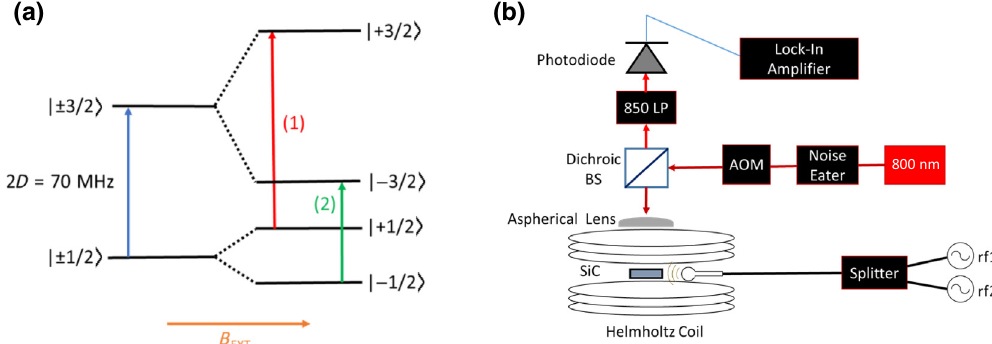
FIG. 1. V2 ground state and experiment setup. (a) Energy-level structure of V2 center with an external magnetic field oriented along the c -axis splitting the degeneracy of the |± 1/2 (cid:4) and |± 3/2 (cid:4) states. (b) Experimental setup for measurement of V2